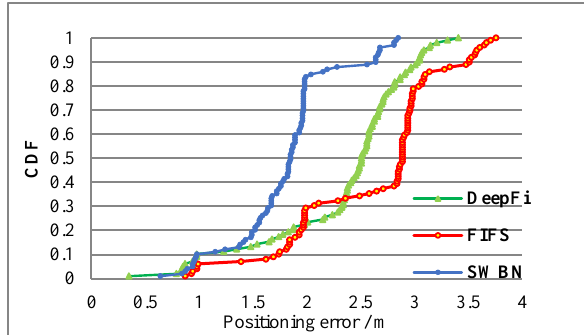
Figure 5. Geomagnetic indoor positioning